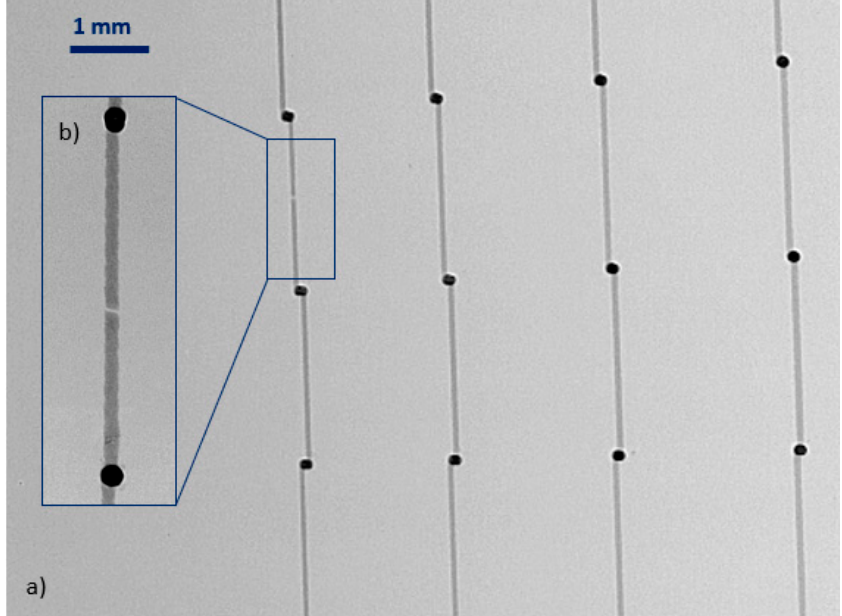
Figure 8. X-ray image of conductor tracks: ( a ) array of intact conductor tracks with a width of 100 µm; ( b ) detail of an interruption. ( b ) detail of an interruption.